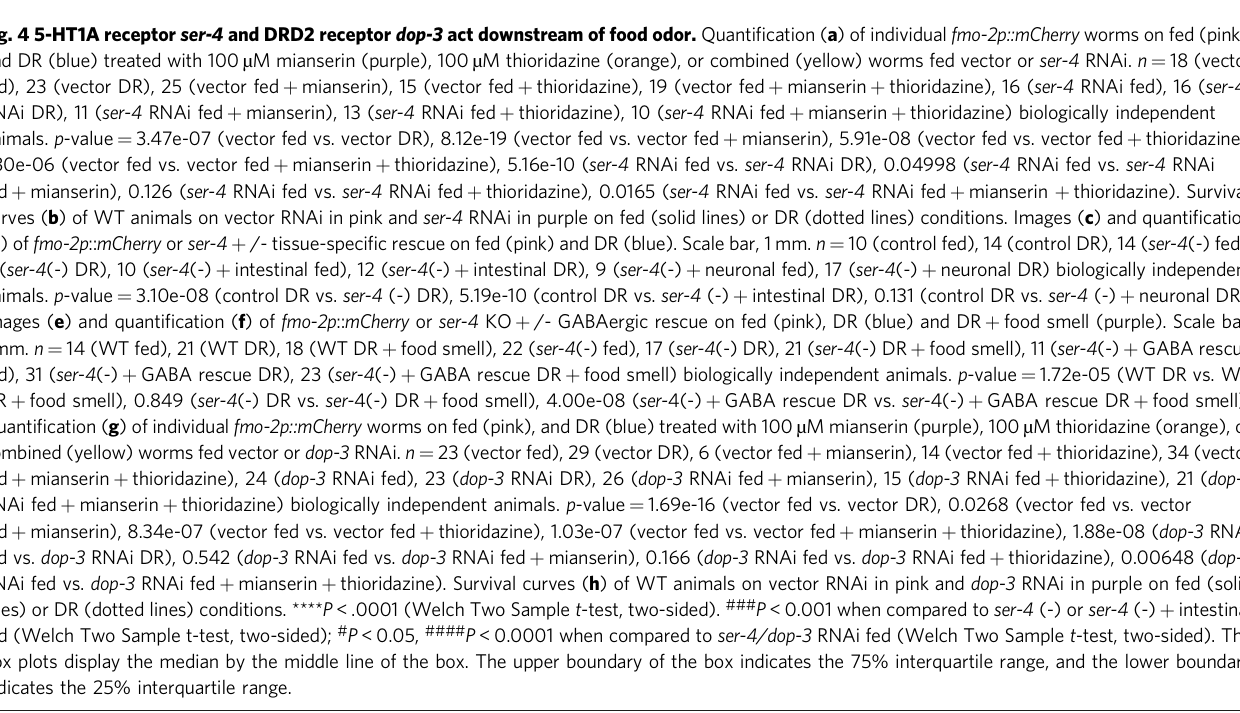
Fig. 4 5-HT1A receptor ser-4 and DRD2 receptor dop-3 act downstream of food odor. Quanti fi cation ( a ) of individual fmo-2p::mCherry worms on fed (pink), and DR (blue) treated with 100 µ M mianserin (purple), 100 µ M thioridazine (orange), or combined (yellow) worms fed vector or ser-4 RNAi. n = 18 (vector fed), 23 (vector DR), 25 (vector fed + mianserin), 15 (vector fed + thioridazine), 19 (vector fed + mianserin + thioridazine), 16 ( ser-4 RNAi fed), 16 ( ser-4 RNAi DR), 11 ( ser-4 RNAi fed + mianserin), 13 ( ser-4 RNAi fed + thioridazine), 10 ( ser-4 RNAi fed + mianserin + thioridazine) biologically independent animals. p -value = 3.47e-07 (vector fed vs. vector DR), 8.12e-19 (vector fed vs. vector fed + mianserin), 5.91e-08 (vector fed vs. vector fed + thioridazine), 1.30e-06 (vector fed vs. vector fed + mianserin + thioridazine), 5.16e-10 ( ser-4 RNAi fed vs. ser-4 RNAi DR), 0.04998 ( ser-4 RNAi fed vs. ser-4 RNAi fed + mianserin), 0.126 ( ser-4 RNAi fed vs. ser-4 RNAi fed + thioridazine), 0.0165 ( ser-4 RNAi fed vs. ser-4 RNAi fed + mianserin + thioridazine). Survival curves ( b ) of WT animals on vector RNAi in pink and ser-4 RNAi in purple on fed (solid lines) or DR (dotted lines) conditions. Images ( c ) and quanti fi cation ( d ) of fmo-2p :: mCherry or ser-4 + /- tissue-speci fi c rescue on fed (pink) and DR (blue). Scale bar, 1mm. n = 10 (control fed), 14 (control DR), 14 ( ser-4 (-) fed), 8 ( ser-4 (-) DR), 10 ( ser-4 (-) + intestinal fed), 12 ( ser-4 (-) + intestinal DR), 9 ( ser-4 (-) + neuronal fed), 17 ( ser-4 (-) + neuronal DR) biologically independent animals. p -value = 3.10e-08 (control DR vs. ser-4 (-) DR), 5.19e-10 (control DR vs. ser-4 (-) + intestinal DR), 0.131 (control DR vs. ser-4 (-) + neuronal DR). Images ( e ) and quanti fi cation ( f ) of fmo-2p :: mCherry or ser-4 KO + /- GABAergic rescue on fed (pink), DR (blue) and DR + food smell (purple). Scale bar, 1mm. n = 14 (WT fed), 21 (WT DR), 18 (WT DR + food smell), 22 ( ser-4 (-) fed), 17 ( ser-4 (-) DR), 21 ( ser-4 (-) DR + food smell), 11 ( ser-4 (-) + GABA rescue fed), 31 ( ser-4 (-) + GABA rescue DR), 23 ( ser-4 (-) + GABA rescue DR + food smell) biologically independent animals. p -value = 1.72e-05 (WT DR vs. WT DR + food smell), 0.849 ( ser-4 (-) DR vs. ser- 4(-) DR + food smell), 4.00e-08 ( ser- 4(-) + GABA rescue DR vs. ser- 4(-) + GABA rescue DR + food smell). Quanti fi cation ( g ) of individual fmo-2p::mCherry worms on fed (pink), and DR (blue) treated with 100 µ M mianserin (purple), 100 µ M thioridazine (orange), or combined (yellow) worms fed vector or dop-3 RNAi. n = 23 (vector fed), 29 (vector DR), 6 (vector fed + mianserin), 14 (vector fed + thioridazine), 34 (vector fed + mianserin + thioridazine), 24 ( dop-3 RNAi fed), 23 ( dop-3 RNAi DR), 26 ( dop-3 RNAi fed + mianserin), 15 ( dop-3 RNAi fed + thioridazine), 21 ( dop-3 RNAi fed + mianserin + thioridazine) biologically independent animals. p -value = 1.69e-16 (vector fed vs. vector DR), 0.0268 (vector fed vs. vector fed + mianserin), 8.34e-07 (vector fed vs. vector fed + thioridazine), 1.03e-07 (vector fed vs. vector fed + mianserin + thioridazine), 1.88e-08 ( dop-3 RNAi fed vs. dop-3 RNAi DR), 0.542 ( dop-3 RNAi fed vs. dop-3 RNAi fed + mianserin), 0.166 ( dop-3 RNAi fed vs. dop-3 RNAi fed + thioridazine), 0.00648 ( dop-3 RNAi fed vs. dop-3 RNAi fed + mianserin + thioridazine). Survival curves ( h ) of WT animals on vector RNAi in pink and dop-3 RNAi in purple on fed (solid lines) or DR (dotted lines) conditions. **** P <.0001 (Welch Two Sample t -test, two-sided). ### P < 0.001 when compared to ser-4 (-) or ser-4 (-) + intestinal fed (Welch Two Sample t-test, two-sided); # P <0.05, #### P <0.0001 when compared to ser-4/dop-3 RNAi fed (Welch Two Sample t -test, two-sided). The box plots display the median by the middle line of the box. The upper boundary of the box indicates the 75% interquartile range, and the lower boundary indicates the 25% interquartile